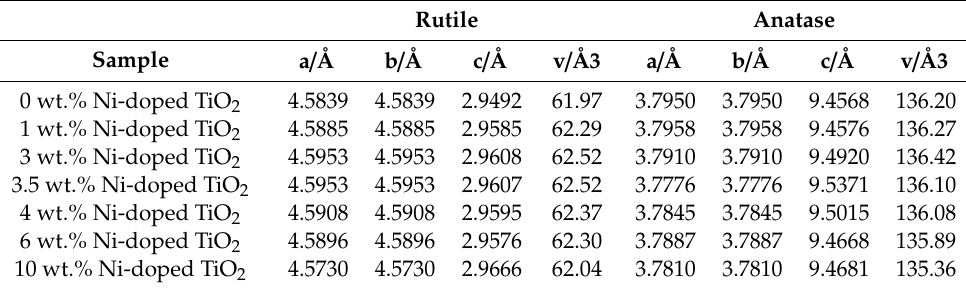
Table 1. Refined unit-cell parameters for Ni-doped TiO 2 nanofibers.